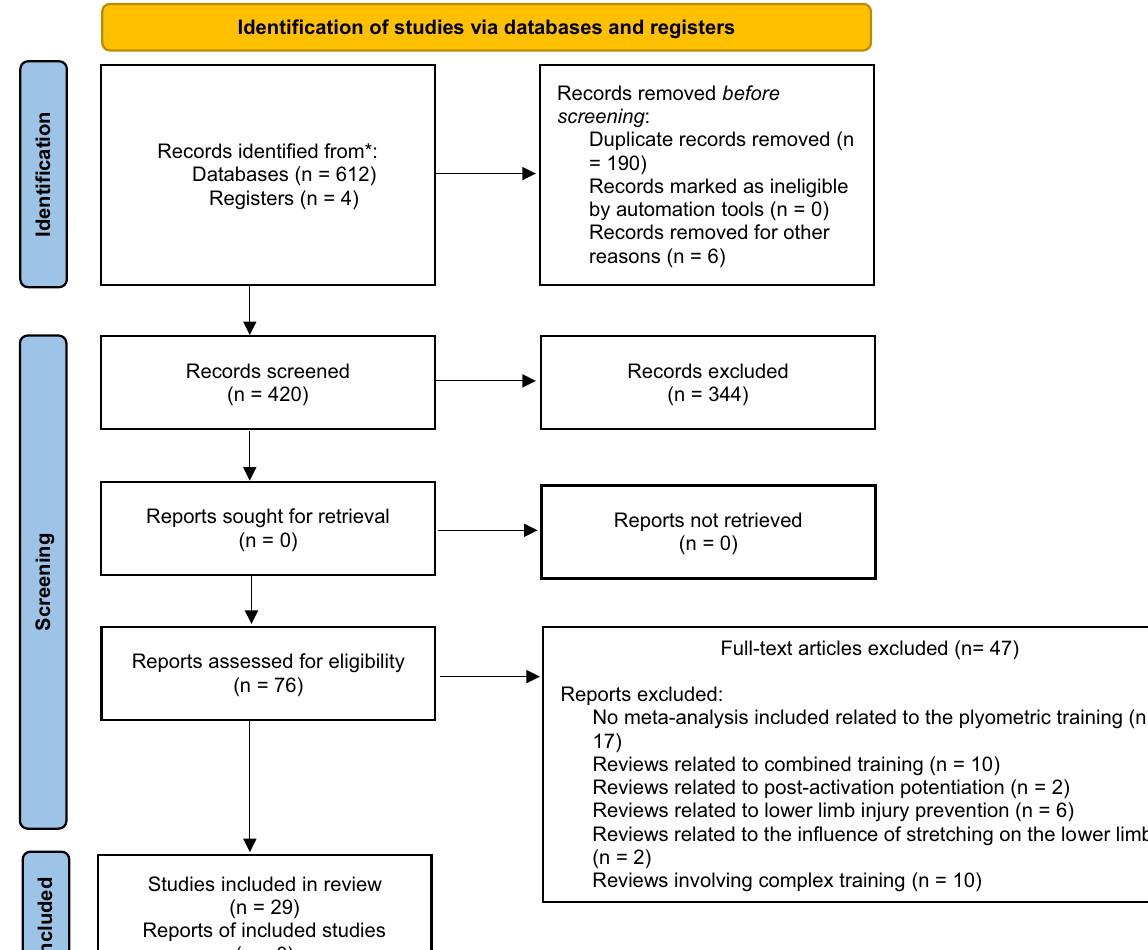
Fig. 1 PRISMA flow diagram for the systematic